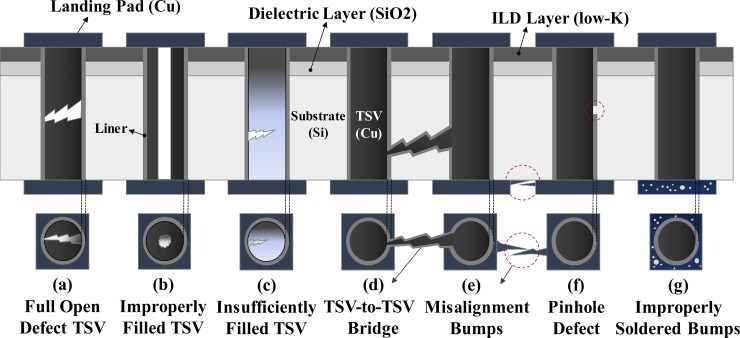
Various TSV defects.